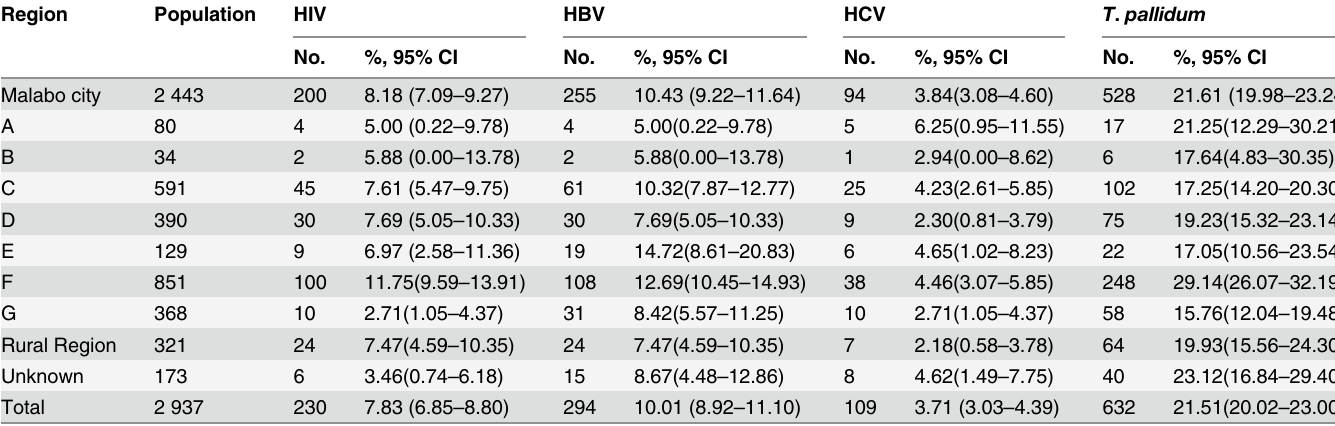
Table 3. The seroprevalence of HIV, HBV, HCV and Treponema pallidum in different regions with diverse populations on Bioko Island, Equatorial Guinea, 2011 –